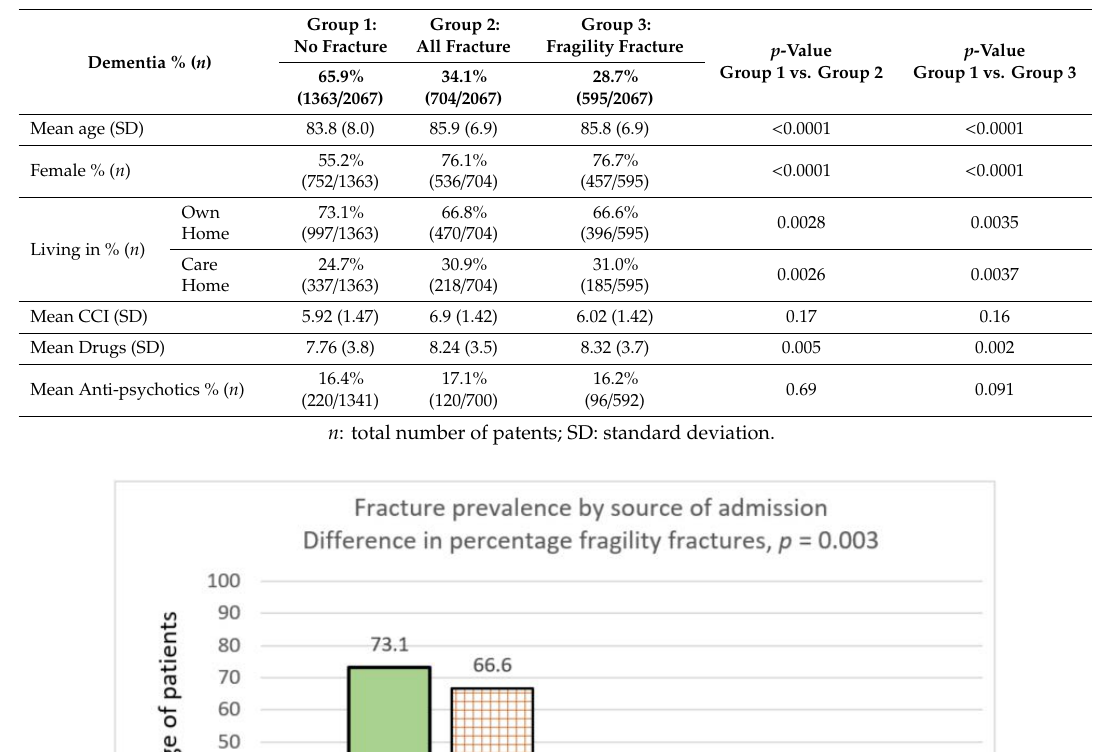
Table 1. Profile of dementia and prevalent fracture.